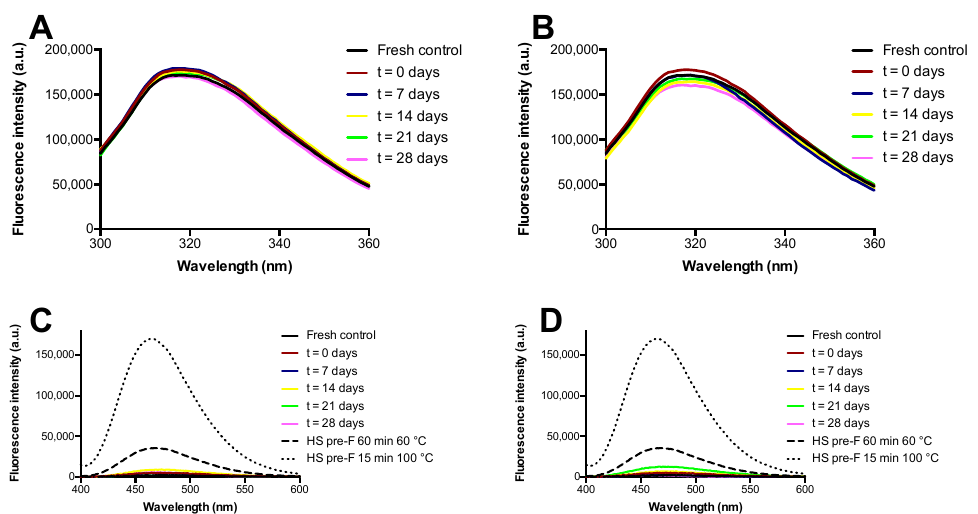
Figure 5. Stability of the freeze-dried pre-F-containing powder using fluorescence spectroscopy. ( A ) and ( B ) show the results of intrinsic fluorescence spectroscopy at storage temperatures of 37 ◦ C and 60 ◦ C, while ( C ) and ( D ) show the results of extrinsic fluorescence spectroscopy at storage temperatures of 37 ◦ C and 60 ◦ C. For each time point, the mean of three independent measurements is shown. Since the curves almost completely overlapped, error bars are not presented.